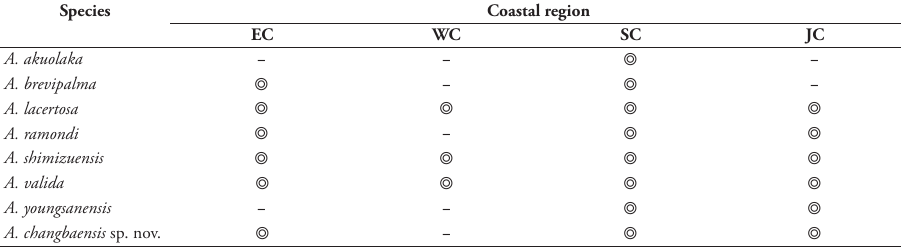
Table 1. Distribution of the species of Ampithoe in coastal regions of Korea: EC, Eastern coast; WC, Western coast; SC, Southern coast; JC, Jeju coast (distribution data cited from Kim [2011] and Jung and Yoon [2014]).